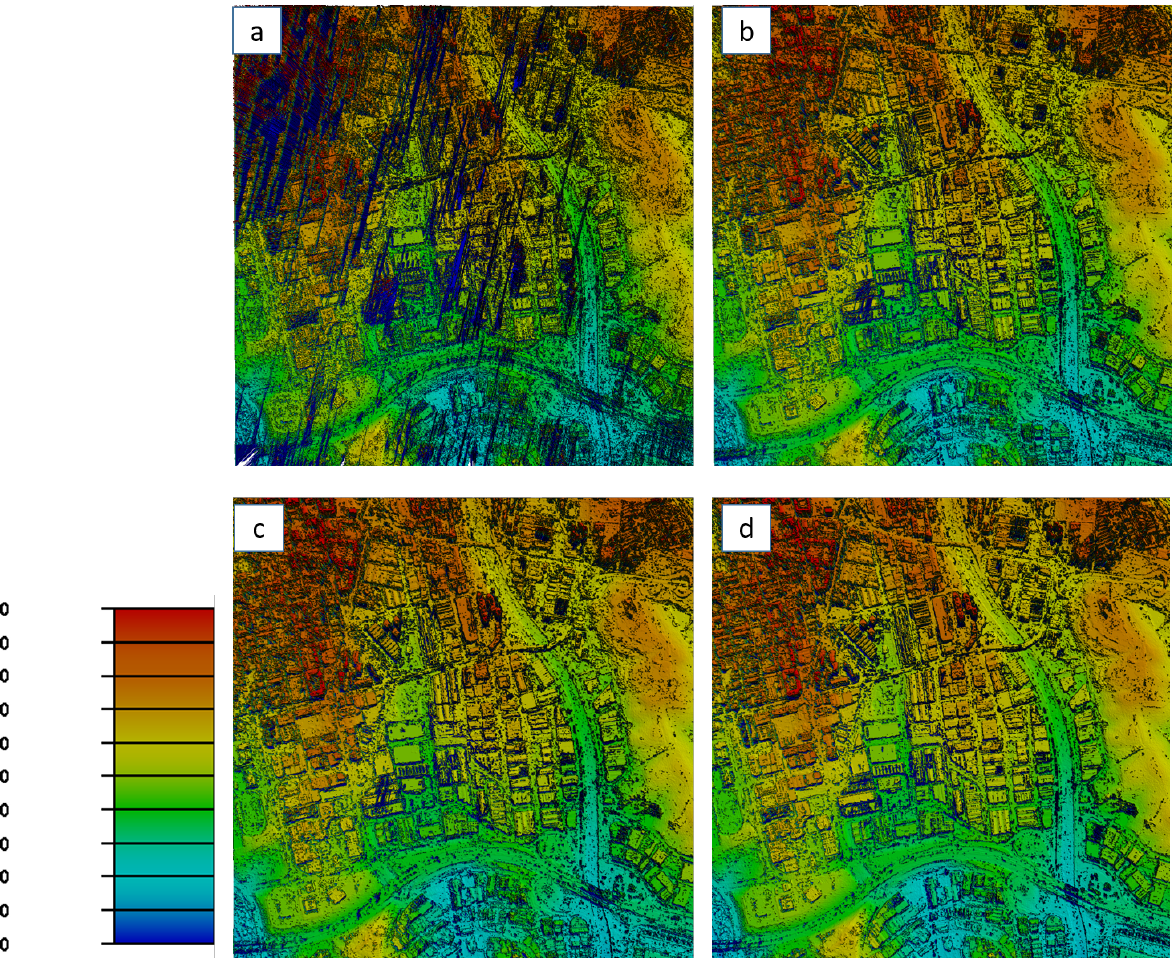
Figure 6. DSM results by search window (a: Fixed size search window (size: 5); b: Fixed size search window (size: 9); b: Fixed size search window (size: 13); d: Multi-dimensional search window)